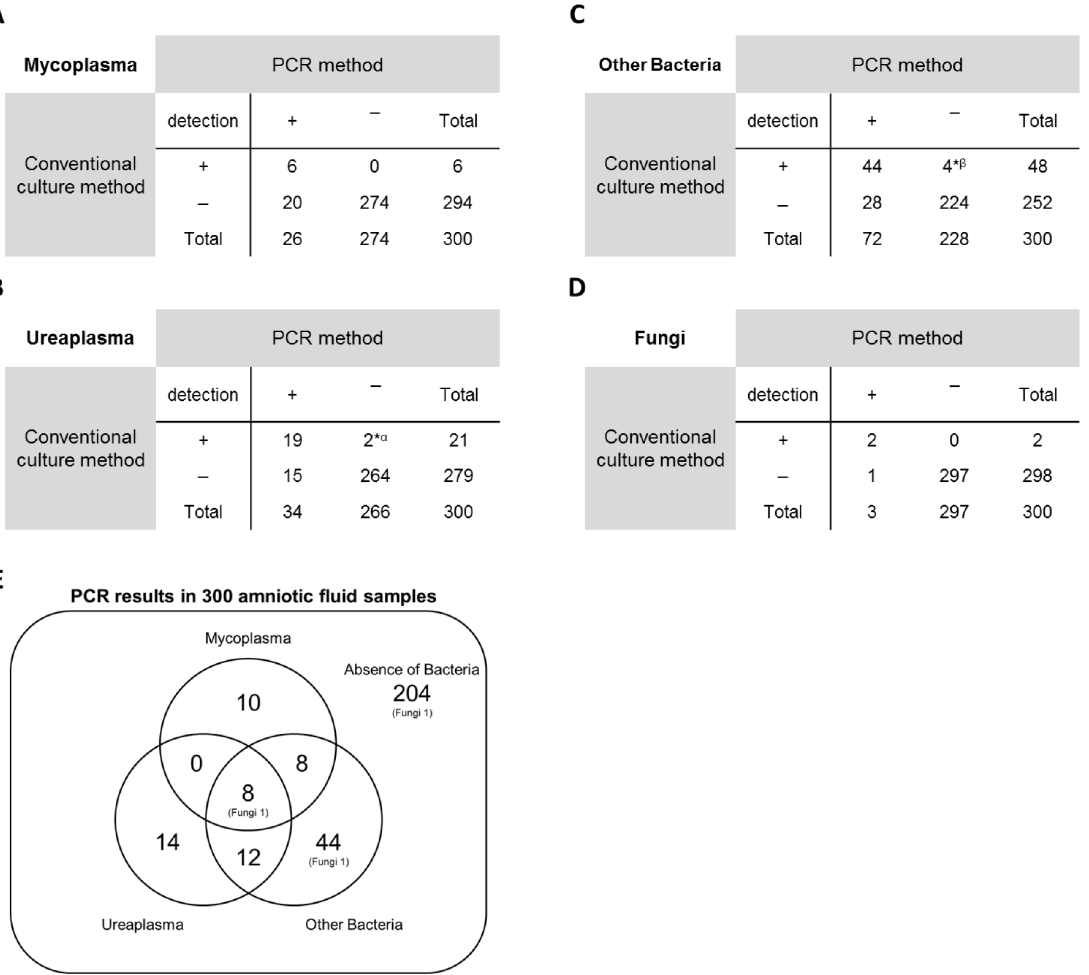
Fig 3. The result of a comparison of the novel PCR and conventional culture results for detecting Mycoplasma, Ureaplasma, other bacteria and fungi. Based on the detection level (positive and negative), 93.3% (280/300) of Mycoplasma , 94.3% (283/300) of the Ureaplasma , 89.3% (268/300) of other bacteria and 99.7% (299/300) of fungi results matched the culture results. (A) The numbers of cases with detected and non-detected Mycoplasma in 300 amniotic fluid samples. (B) The numbers of cases with detected and non-detected Ureaplasma in 300 amniotic fluid samples. (C) The numbers of cases with detected and non-detected bacteria other than Mycoplasma and Ureaplasma in 300 amniotic fluid samples. (D) The numbers of cases with detected and non-detected fungi in 300 amniotic fluid samples. (E) PCR results in 300 amniotic fluid samples. * α : Because of multiple colonies of other bacteria, colony- forming Ureaplasma could not be confirmed. In these cases, the existence of Ureaplasma was judged only by checking the color changes of the medium from yellow to red. * β : Four samples were PCR-negative but culture-positive, and the bacteria detected by only the culture method were Corynebacterium species and Lactobacillus species (transvaginal amniocentesis), Corynebacterium species and Lactobacillus species (vaginal delivery), Corynebacterium species and Lactobacillus species (vaginal delivery) and Lactobacillus species (vaginal